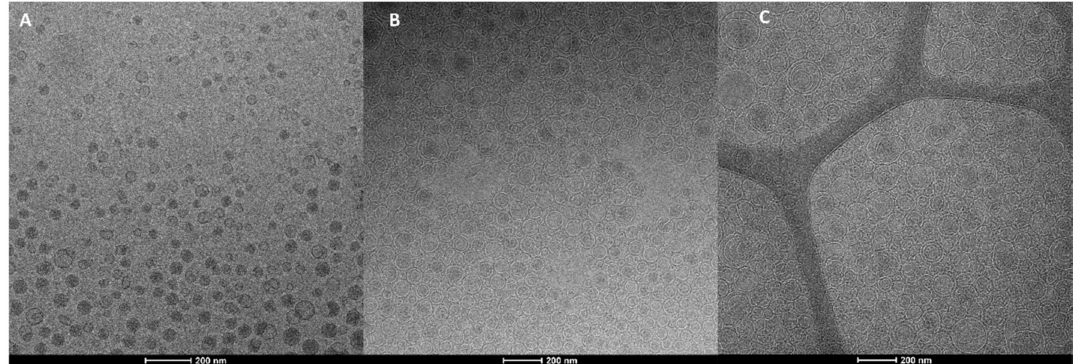
Figure 1. Representative cryo-TEM images of 10liposomes ( A ), 10argan-liposomes ( B ) and 10argan-hyalurosomes ( C